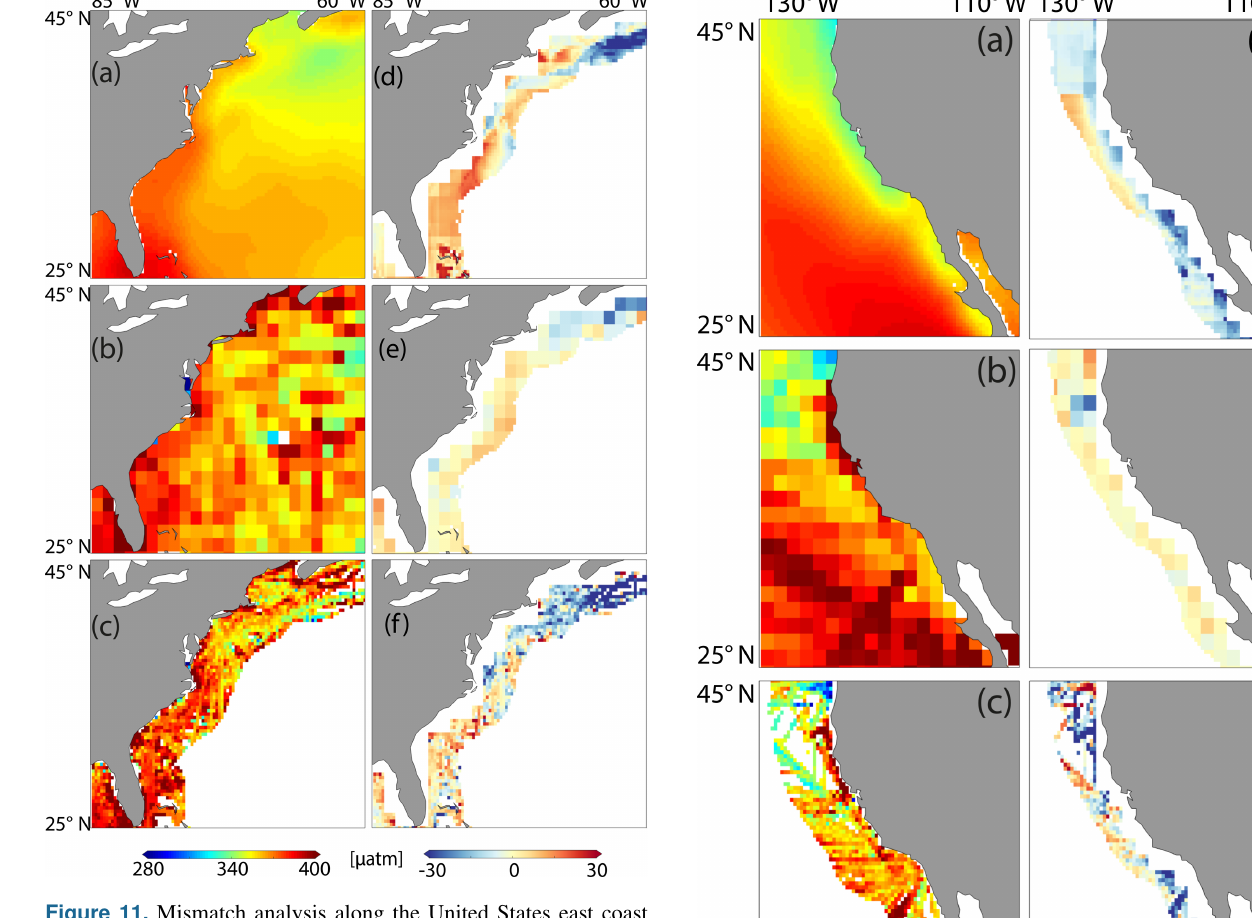
Figure 11. Mismatch analysis along the United States east coast for the 1998 through 2015 period. The climatological mean p CO 2 is reported for (a) the merged product, (b) all available SOCATv5 data for the open ocean, and (c) all coastal SOCATv5 data (as illustrated in Fig. 1 for the global ocean). The p CO 2 mismatch is illustrated in (d) as the difference between NN coast and NN open . Panel (e) reports the mismatch between the NN open and the SOCATv5 open-ocean dataset along the overlap area, while panel (f) reports the mismatch between the coastal product and the SOCATv5 coastal dataset along the overlap area.